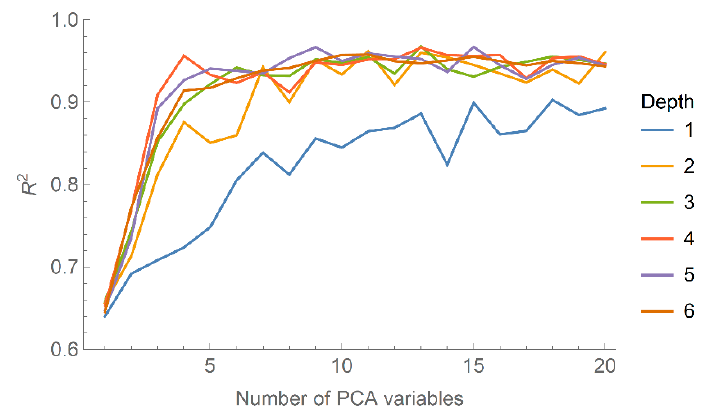
Figure 3. The R 2 coefficient describing the accuracy of the predicted binding energies from the neural network as a function of the number of PCA variables included, shown for network depths ranging from 1 to 6.